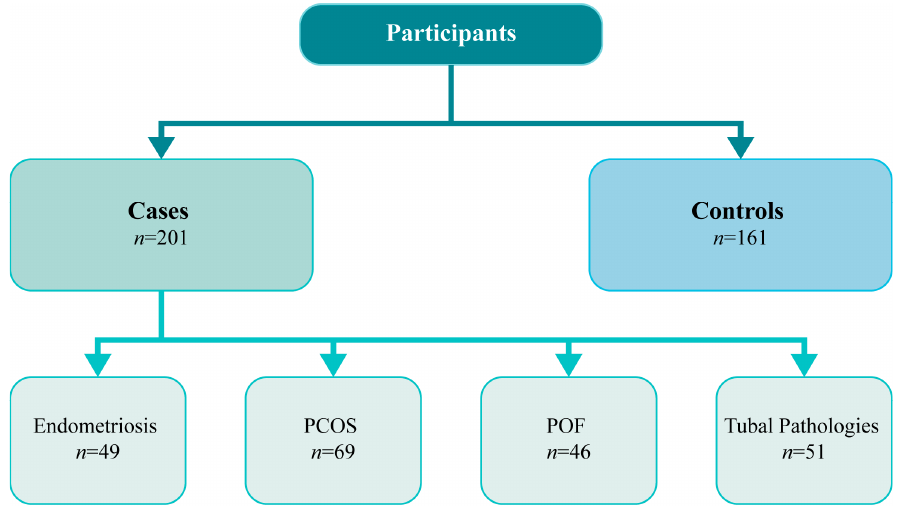
Figure 1. Flowchart diagram of participants of the